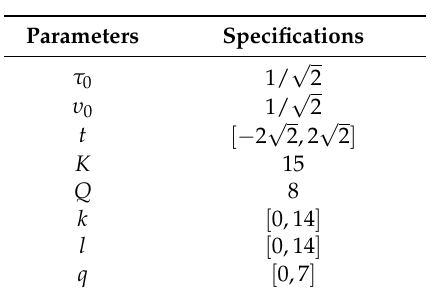
Table 2. Important parameters in the IOTA